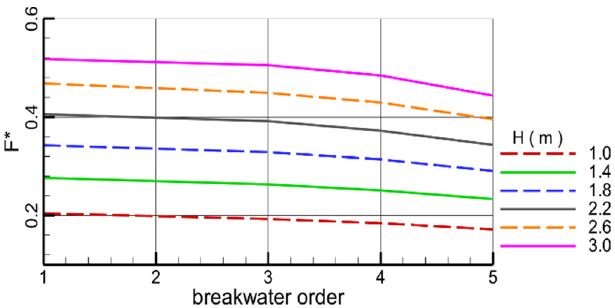
Figure 23. The maximum forces on the breakwaters with different